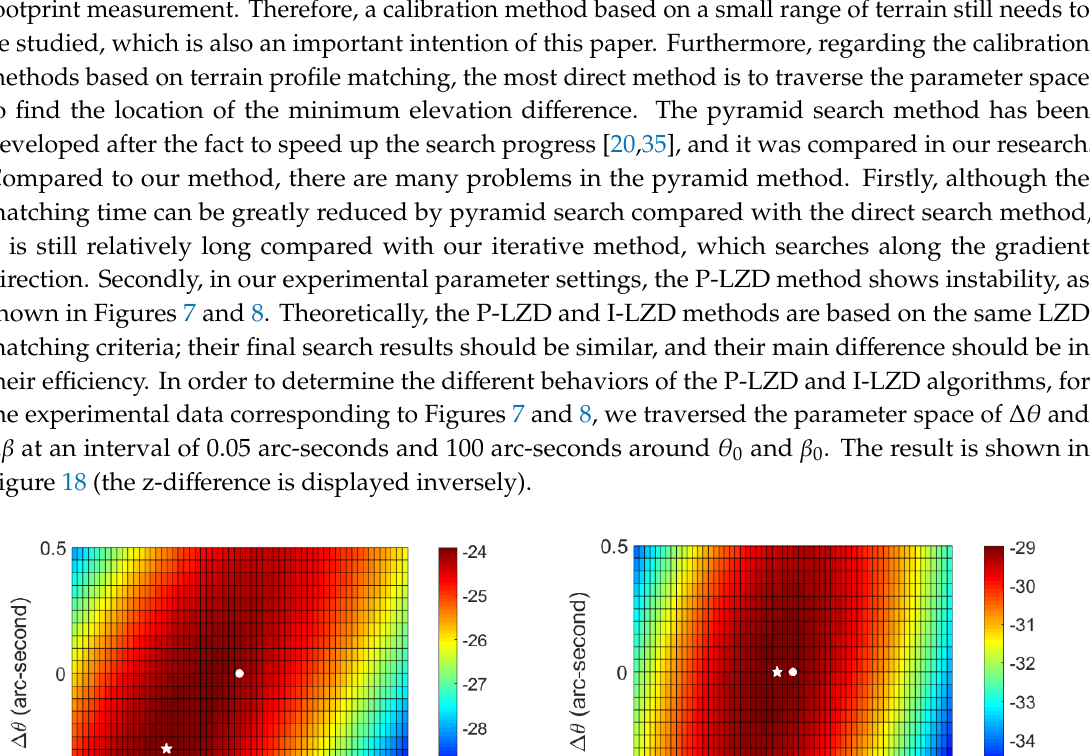
Figure 18. Z-difference variation with different θ∆ and β∆ . The mark “ Figure 18. Z-di ff erence variation with di ff erent ∆ θ and ∆ β . The mark “ (cid:70) ” corresponds to the actual least z-di ff erence position. The mark “ (cid:8) ” corresponds to the theoretical least z-di ff erence position. actual least z-difference position. The mark “ ● ” corresponds to the theoretical least z-difference (The unit of the color bar is meters, and the z-di ff erences are shown in negative for display position. (The unit of the color bar is meters, and the z-differences are shown in negative for display purposes).